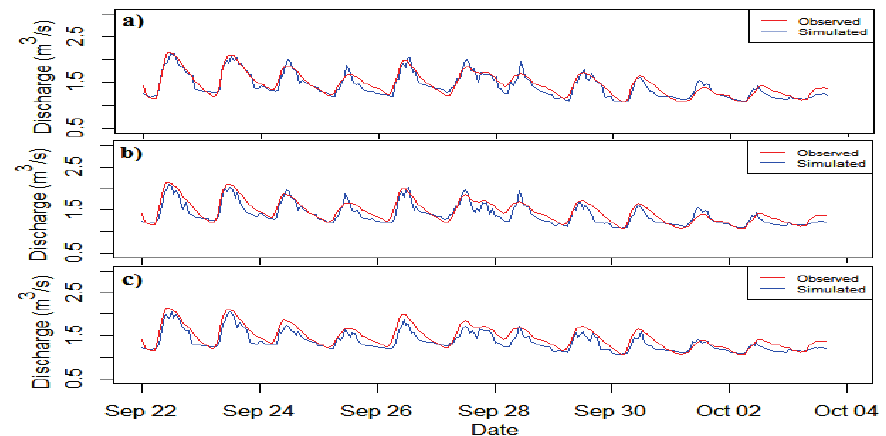
Fig. 2 Time series of simulated discharge vs observed discharge: (a) discharge obtained by varying degree day with aspect and elevation threshold, (b) discharge obtained using elevation threshold for changing degree day factor, and (c) classic degree day